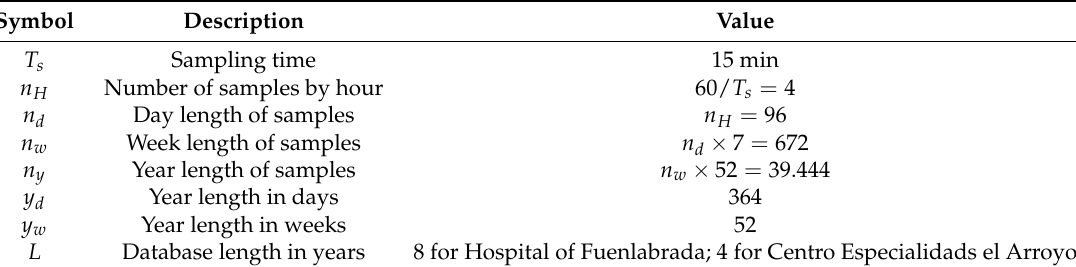
Table 1. Experiment